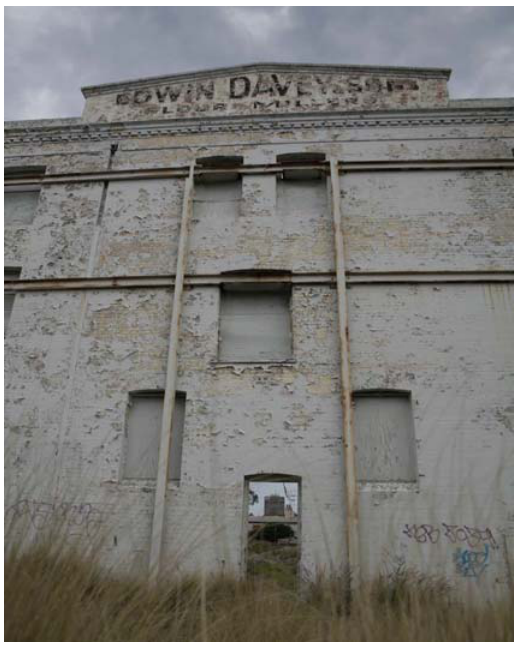
Figure 6. Edwin Davey Flour Mill (2007).